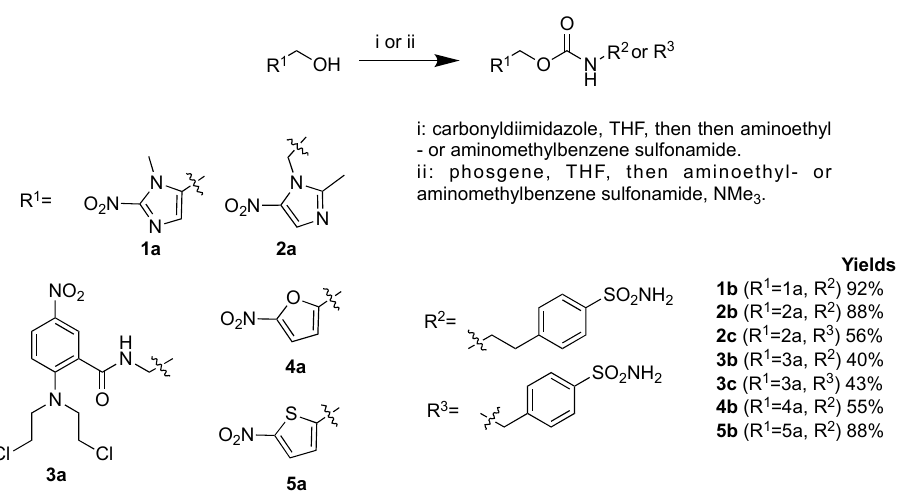
Scheme 1. Synthesis of hypoxia-activated prodrug carbonic anhydrase IX inhibitors (HAP-CAIs) 1b – 4b and 2c – 3c .